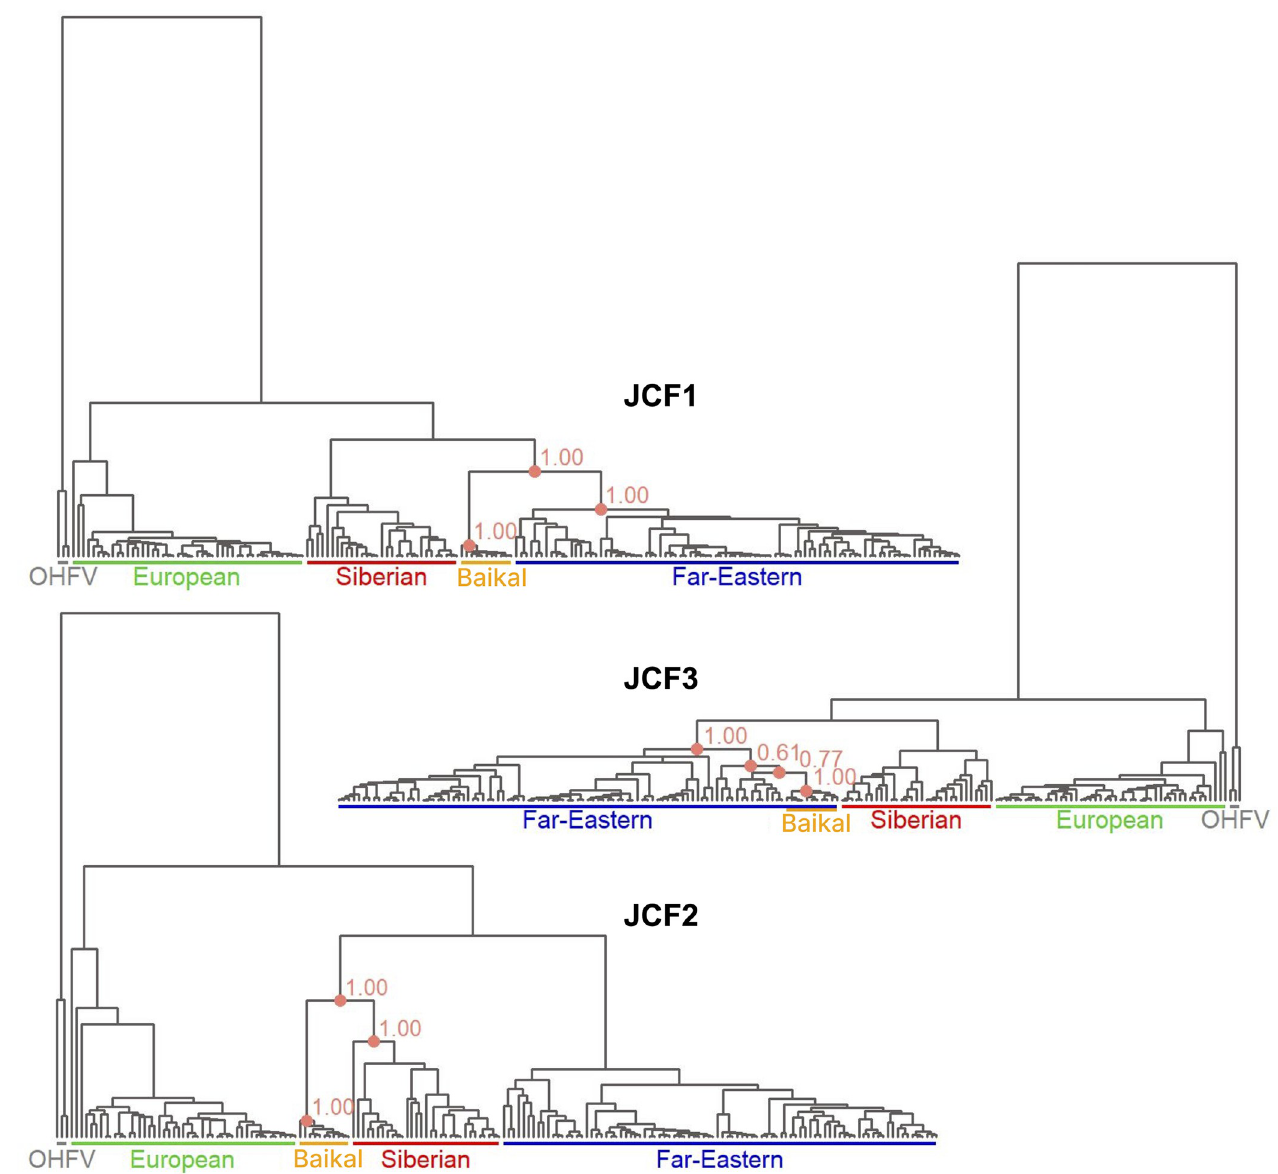
Fig 4. Reconstructed Bayesian phylogenies of TBEV based on the characteristic fragments. Each panel is based on the alignment segment of the corresponding JCF.